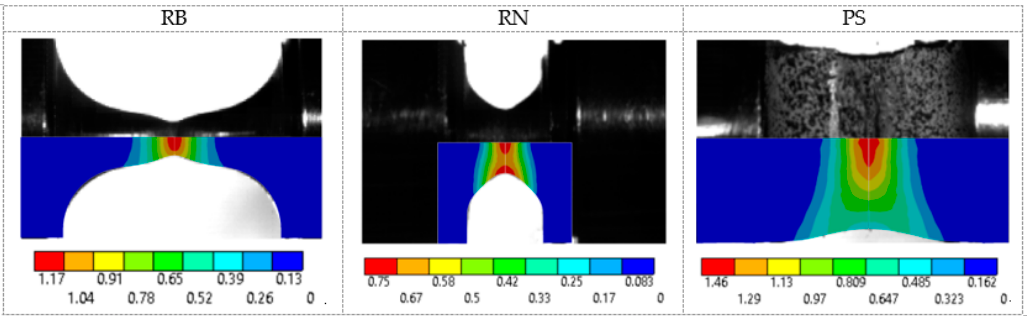
Figure 8. Comparison between experimental and numerical load–displacement curves for RB, RN and PS, for both JC and ZA plasticity models.